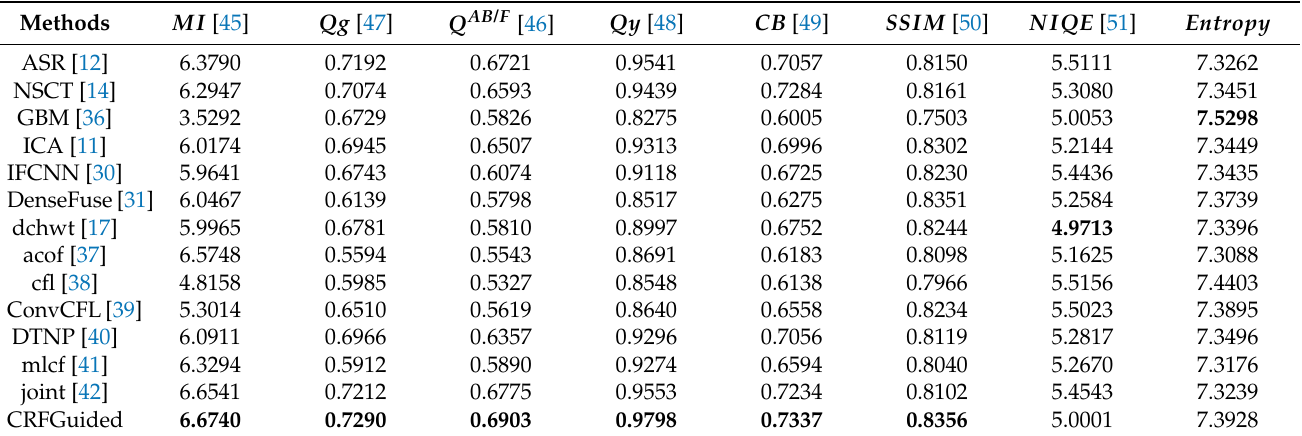
Table 2. Objective evaluation for the grayscale dataset [3]. Lower values for NIQE indicate better fused image quality, while for rest metrics higher values indicate better fused image